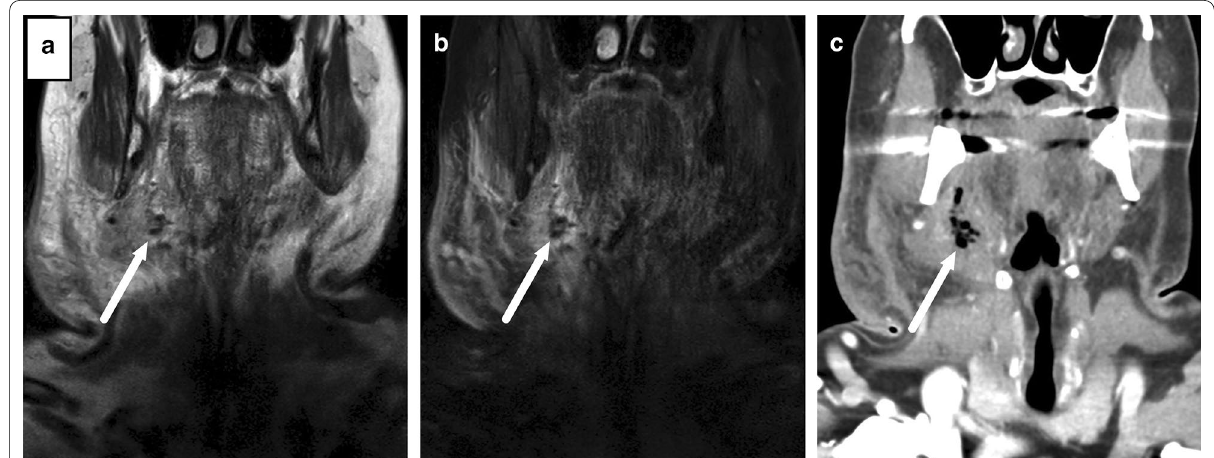
Fig. 5 On MRI, gas appears as small foci of signal void (arrows) on coronal in-phase ( a ) and fat-suppressed T2-weighted ( b ) images but is easier to see on CT (arrow) ( c )